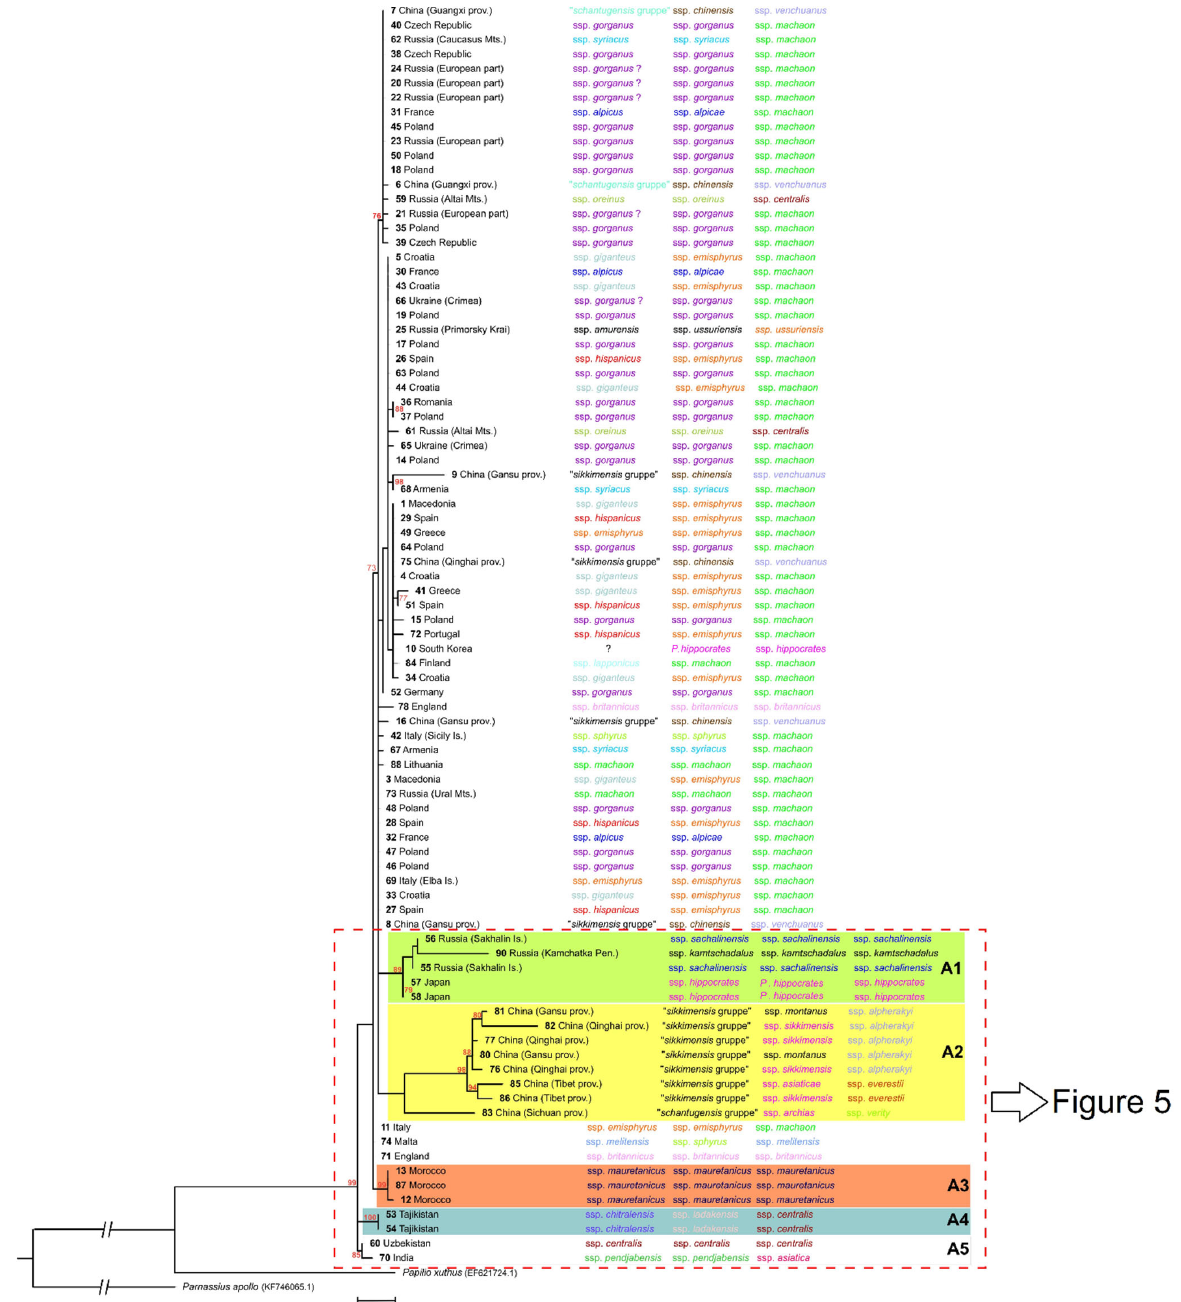
Figure 4. The maximum ‐ likelihood tree derived from a combination of 16S rDNA and cytochrome b sequences. Bootstrap values over 70% are shown next to the branches. The scale bar shows the number of substitutions per site. The individuals on the tree are related to subspecies according to approach of Eller [1] (first column), Seyer [2,7–9] (second column) and Sturm [3] (third column). Clade A1 contains specimens from Sakhalin (specimens 55, 56), Kamchatka (specimen 90) and Japan (specimens 57, 58). The second clade, A2, contains only specimens from China (from the mountainous regions of Gansu, Qinghai and Tibet). In clade A3, only the specimens from Morocco (specimens 12–13, 87) are included. Two smaller clades, A4 and A5, contain two specimens from Tajikistan (specimens 53, 54), and the specimen from Uzbekistan (specimen 60) and India (specimen 70), respectively (see the Figure